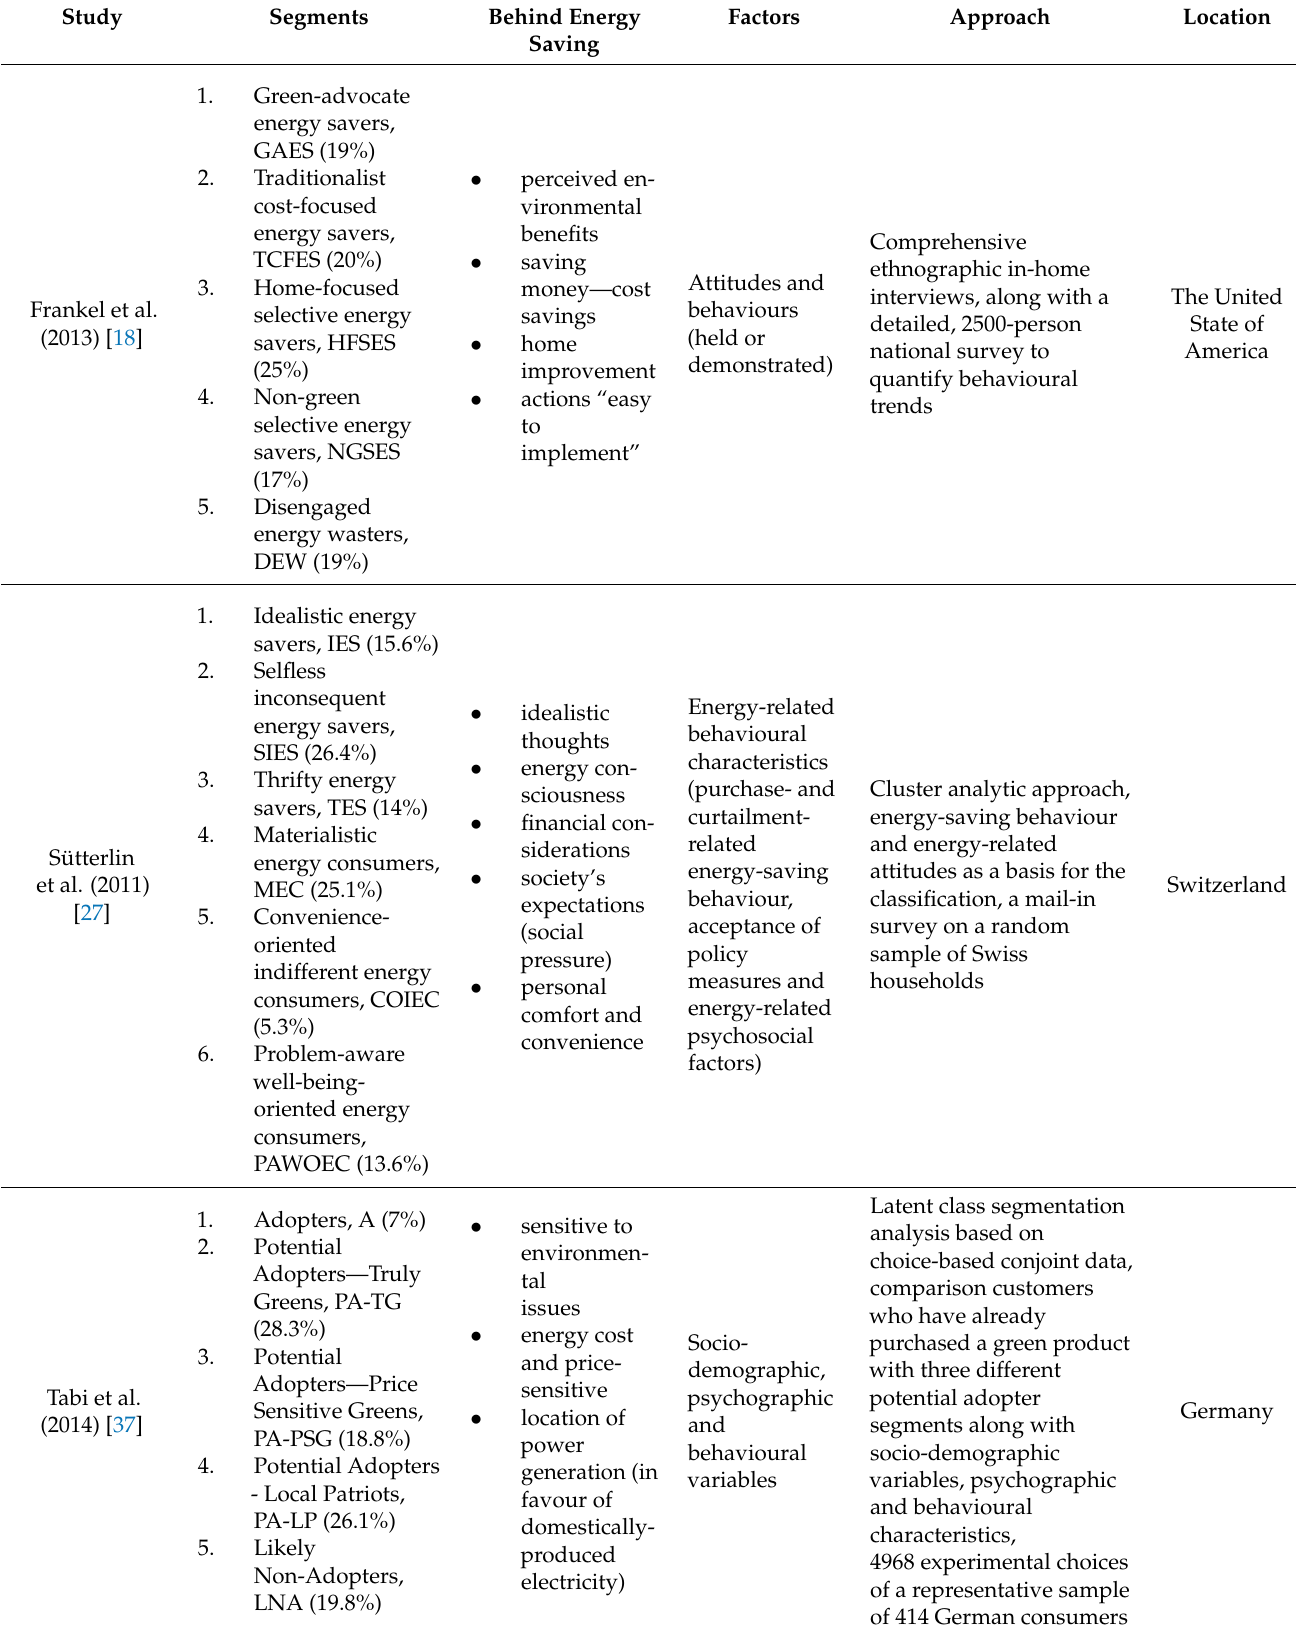
Table 1. Overview of selected studies segmenting energy consumers based on behavioural and psychosocial factors. Study Segments